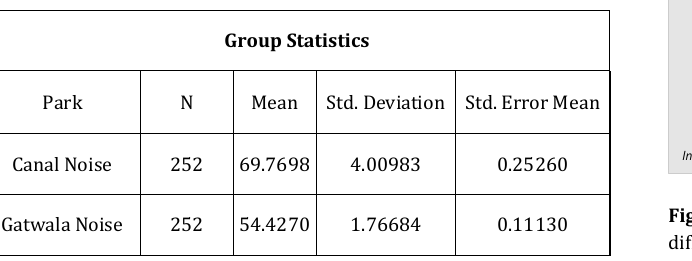
Table 6: Comparison of Average Noise Level between both sites (Site-1 Canal Park and Site-2 Gat Wala Park)